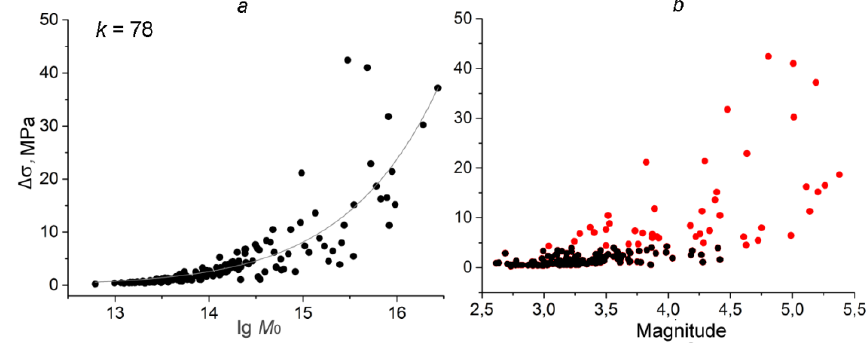
Fig. 9. Distribution of dropped stresses in comparison with the values of lg M 0 ( а ) and the result of clustering ( b ) of the representing points on the graph ∆  ( M